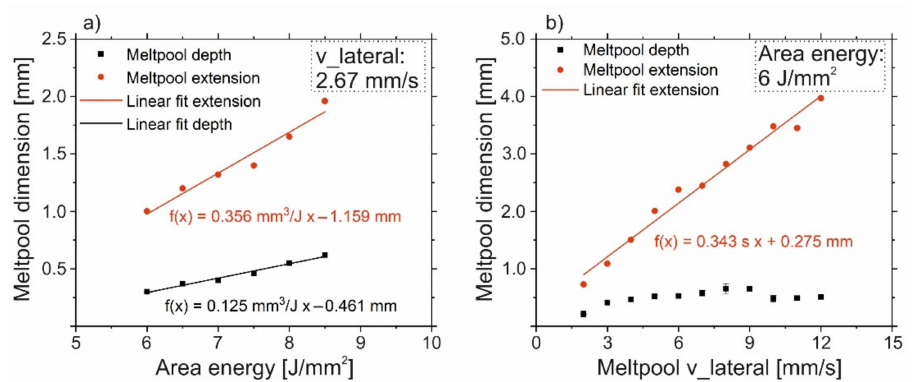
Figure 8. Melt pool dimension. ( a ): Influence of an increasing energy input at a given v_lateral of 2.67 mm/s on the melt pool lateral extension and depth (Figure 3). ( b ): Influence of the v_lateral at a given energy input of 6 J/mm 2 on the melt pool lateral extension and depth (Figure